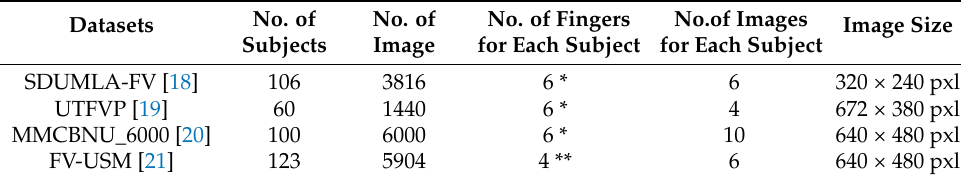
Figure 7. Typical images of three qualities in different databases. ( a ) SDUMLA-HMT ( b ) UTFVP ( c ) MMCBNU_6000 ( d ) FV-USM. Table 1. Details of the datasets used for the